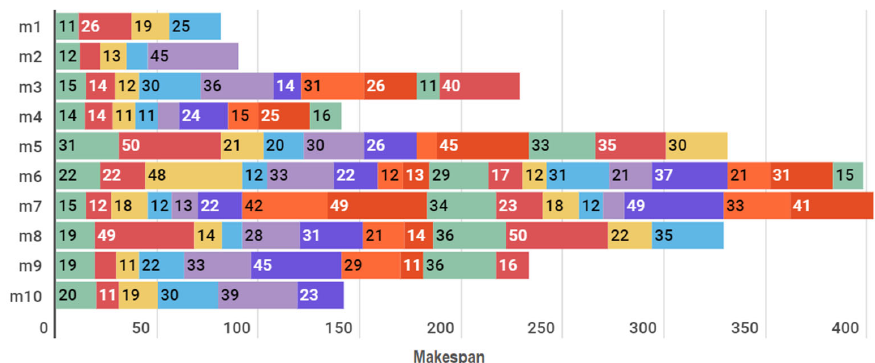
Fig. 8. Gantt chart of solution makespan in the second